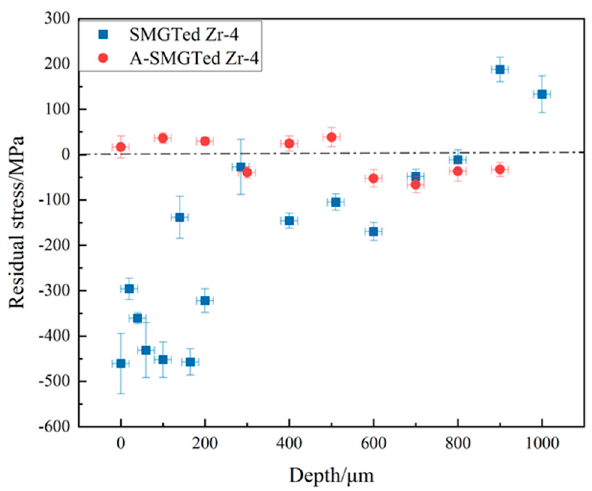
Figure 5. Residual stress distributions with depths of SMGTed and A-SMGTed Zr-4 alloys.